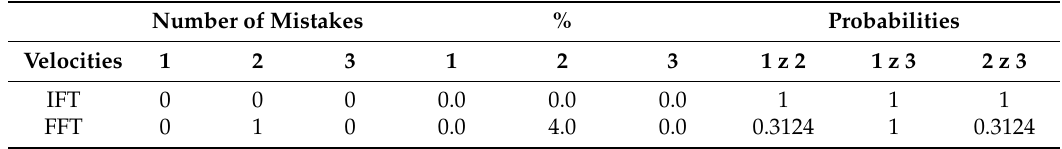
Table 2. Comparison with t-Student’s test of error percentages between speeds for group B ( n = 25) and for each IFT and FFT, separately for ‘head’ mistake.